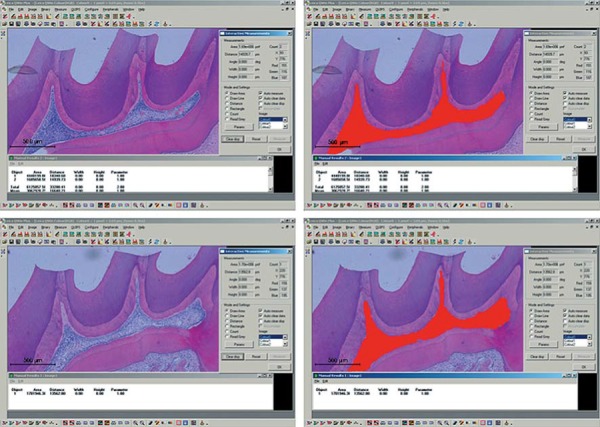
Measurement of the central area of the pulp chamber in the experimental groups using the Leica QWin V3 Image Processing and Analysis Software. The values obtained were analyzed by the Kolmogorov-Smirnov normality test and the One-way ANOVA test (p<0.05)